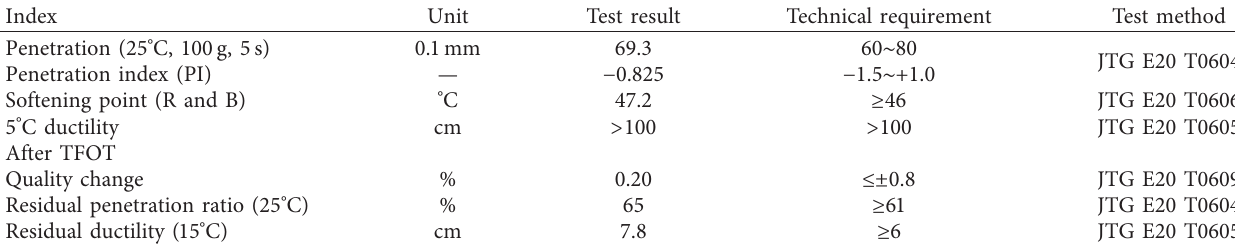
Table 1: Technical indicators of neat asphalt binder.